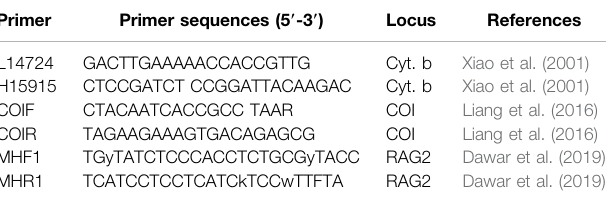
TABLE 3 | Primers used for both PCR ampli fi cation and sequencing in the present